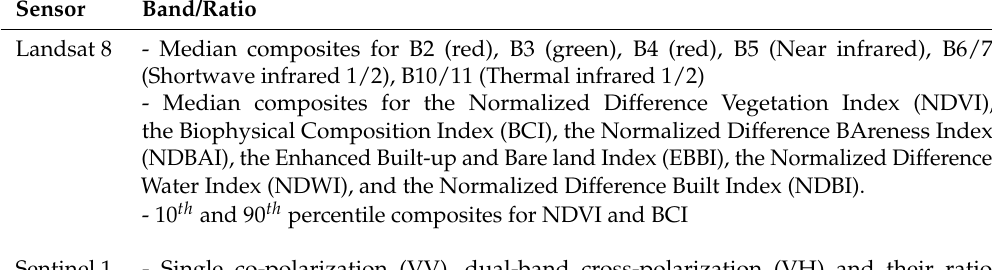
the Biophysical Composition Index (BCI), the Normalized Difference BAreness Index (NDBAI), the Enhanced Built-up and Bare land Index (EBBI), the Normalized Difference Water Index (NDWI), and the Normalized Difference Built Index